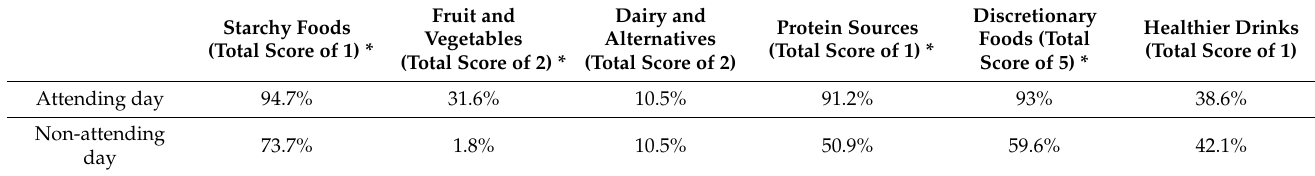
Table 5. The percentage of children meeting each assessable element of the School Food Standards. Statistically significant differences ( p < 0.05) are highlighted with